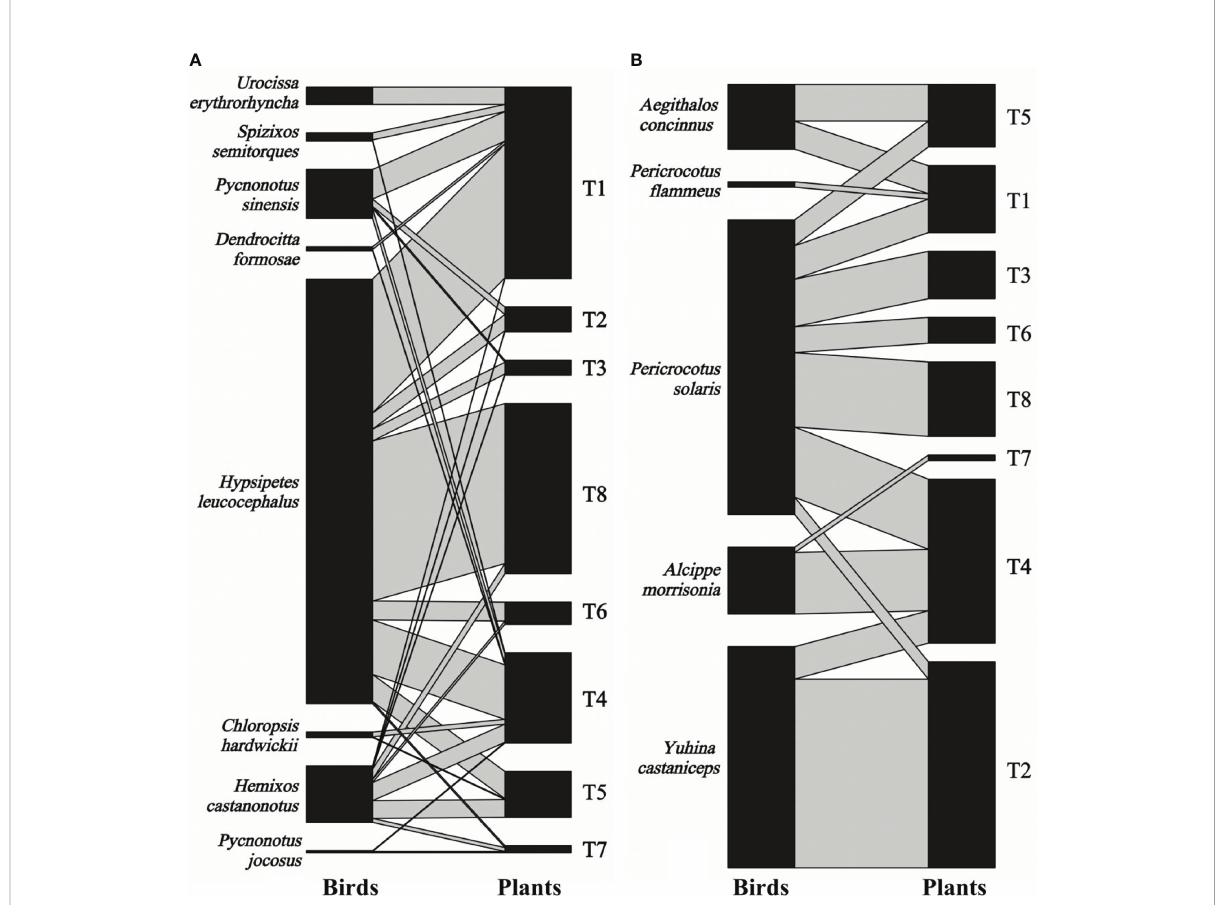
FIGURE 2 Bipartite graph of fruit-bird interaction networks based on bird swallowing (A) and pecking behavior (B) in the yew ecological garden, Fujian province, southeast China from 2018 to 2019. The size of the left square (animals) and right square (plant individuals) indicated the relative abundance of the bird and fruit interaction, respectively. The grey line indicated the interaction between birds and fruits, and the line thickness indicated the interaction strength. T1-T8 indicated the tree numbers 1 to 8.